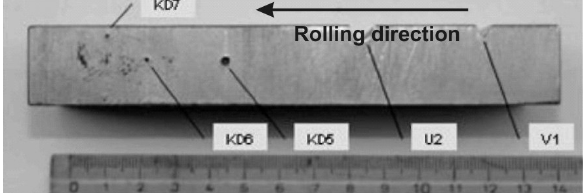
Figure 2b. The location of cracks in the specimen before the physical simulation